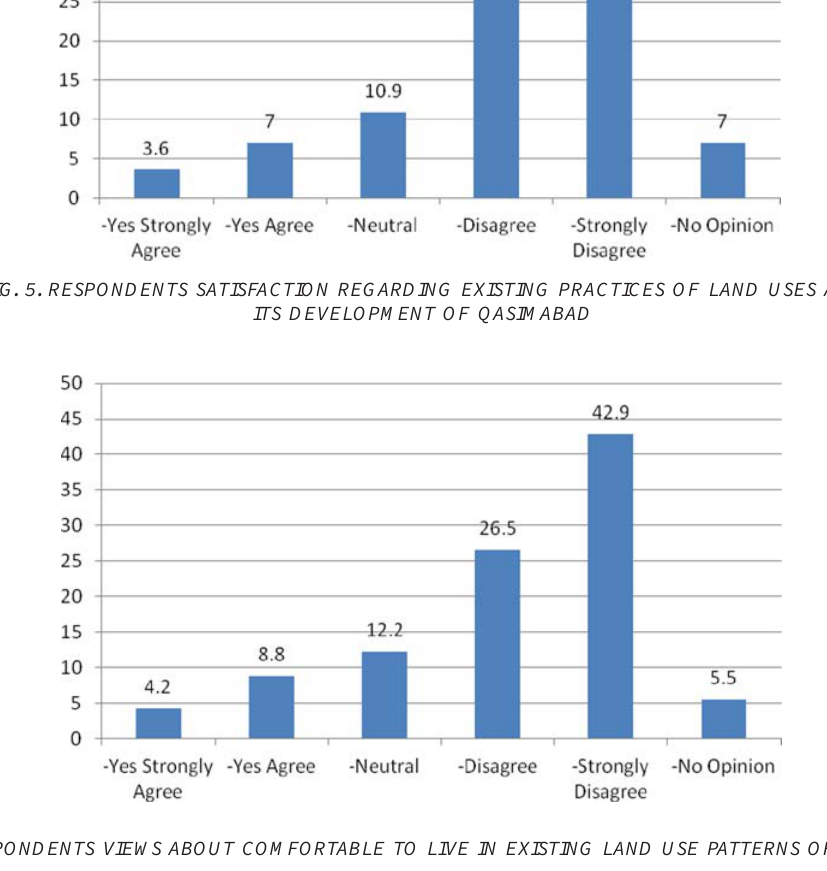
FIG. 6. RESPONDENTS VIEWS ABOUT COMFORTABLE TO LIVE IN EXISTING LAND USE PATTERNS OF